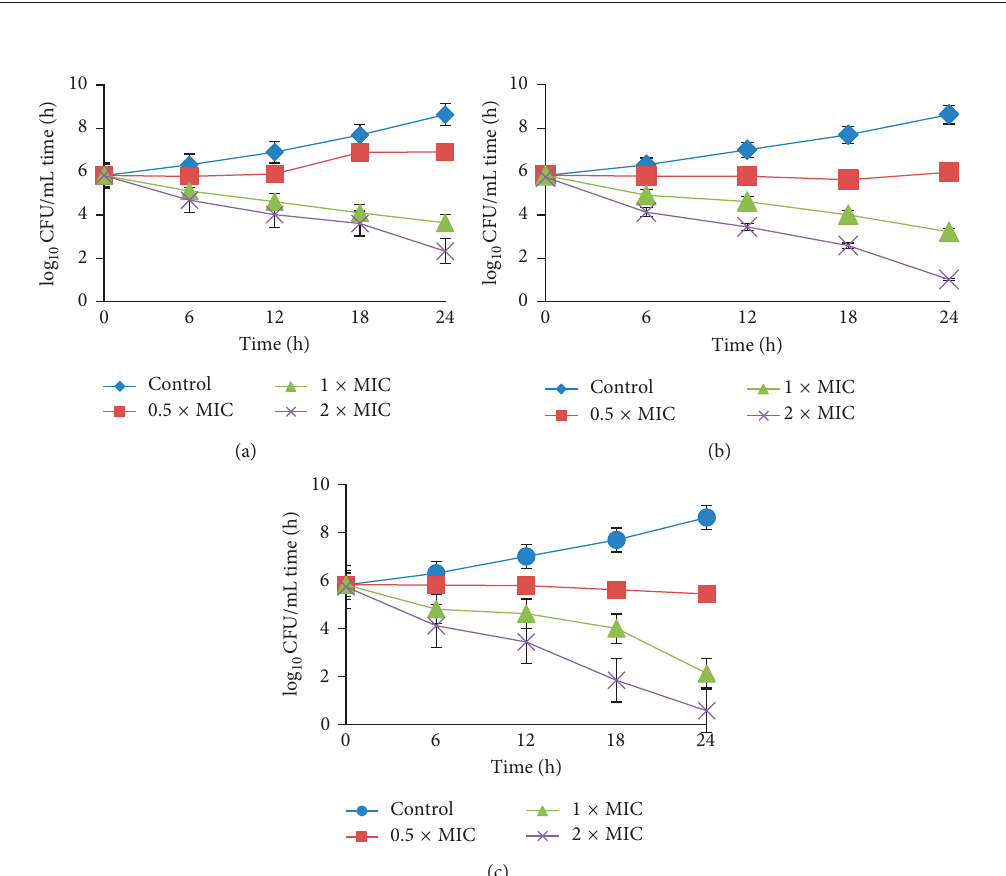
Figure 3: Time-course kinetics of the bactericidal activity of (a) HL, (b) C and the control group treated with normal